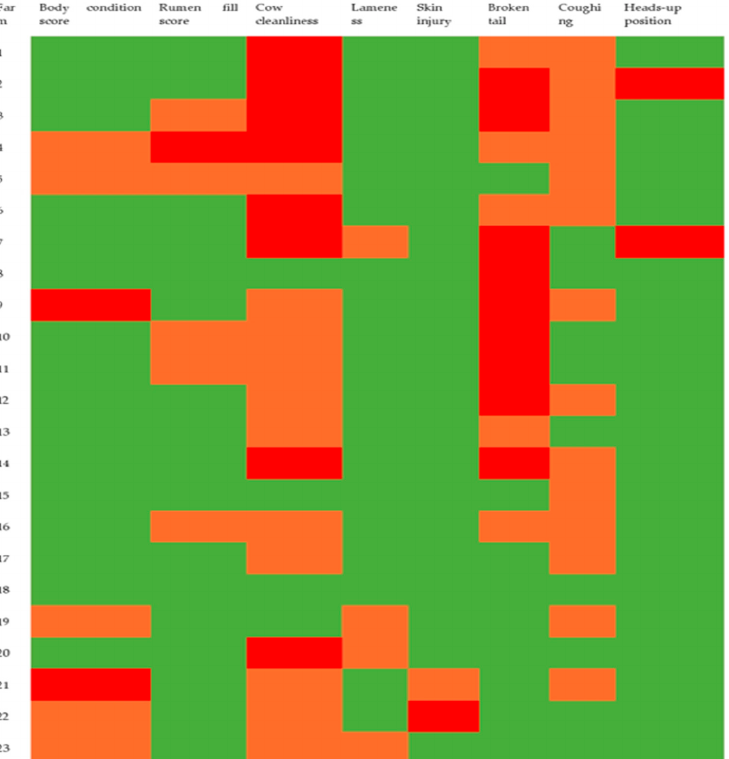
Figure 1. Heatmap representing welfare levels for eight animal-based measures from 23 dairy farms. All measures have three welfare levels (acceptable, green; marginal, orange; or unacceptable, red), except for the heads-up position which has only two levels (acceptable, green; and unacceptable, red). See Table 1 for further details of measurements and